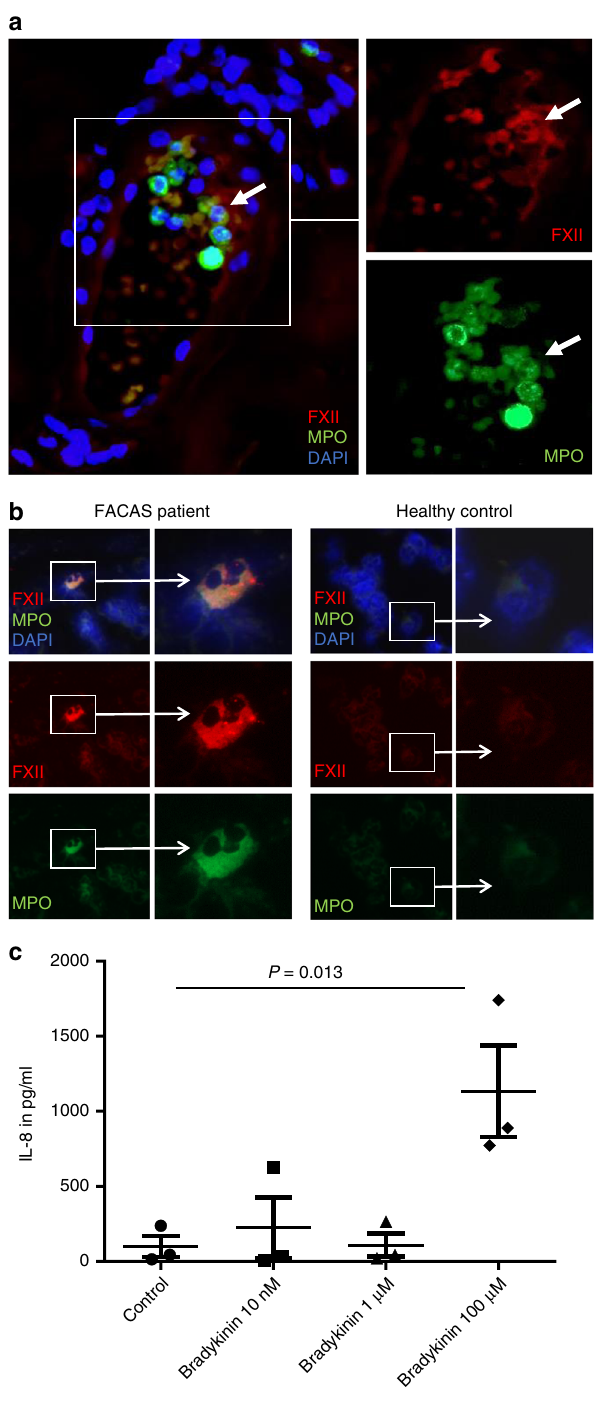
Fig. 4 FXII is expressed by skin and blood neutrophils in FACAS. a Representative image from serial sections of the lesional skin of FACAS patient ca. 1 h after cold exposure. FXII immunoreactivity is restricted to neutrophils at perivascular sites and within blood vessels (white arrows), n = 2 technical replicates. b Exemplary images from cytospins isolated from the peripheral blood of FACAS patients and healthy control subjects. Only single FACAS neutrophils (0.72%), but not healthy control neutrophils (0%), present with double-positive cytoplasmatic staining for FXII and MPO. Original magni fi cation ×400, n = 3 technical replicates. c Peripheral blood mononuclear cells were isolated from healthy control subjects by density-gradient centrifugation and stimulated with increasing doses of bradykinin. IL-8 secretion was assessed by ELISA. Pooled data of n = 3 different donors, n = 2 technical replicates. The graph shows individual data points and the mean ± s.e.m. Statistical signi fi cance is indicated by one-way ANOVA with Sidak ’ s multiple comparisons. Source data are provided as a source data fi